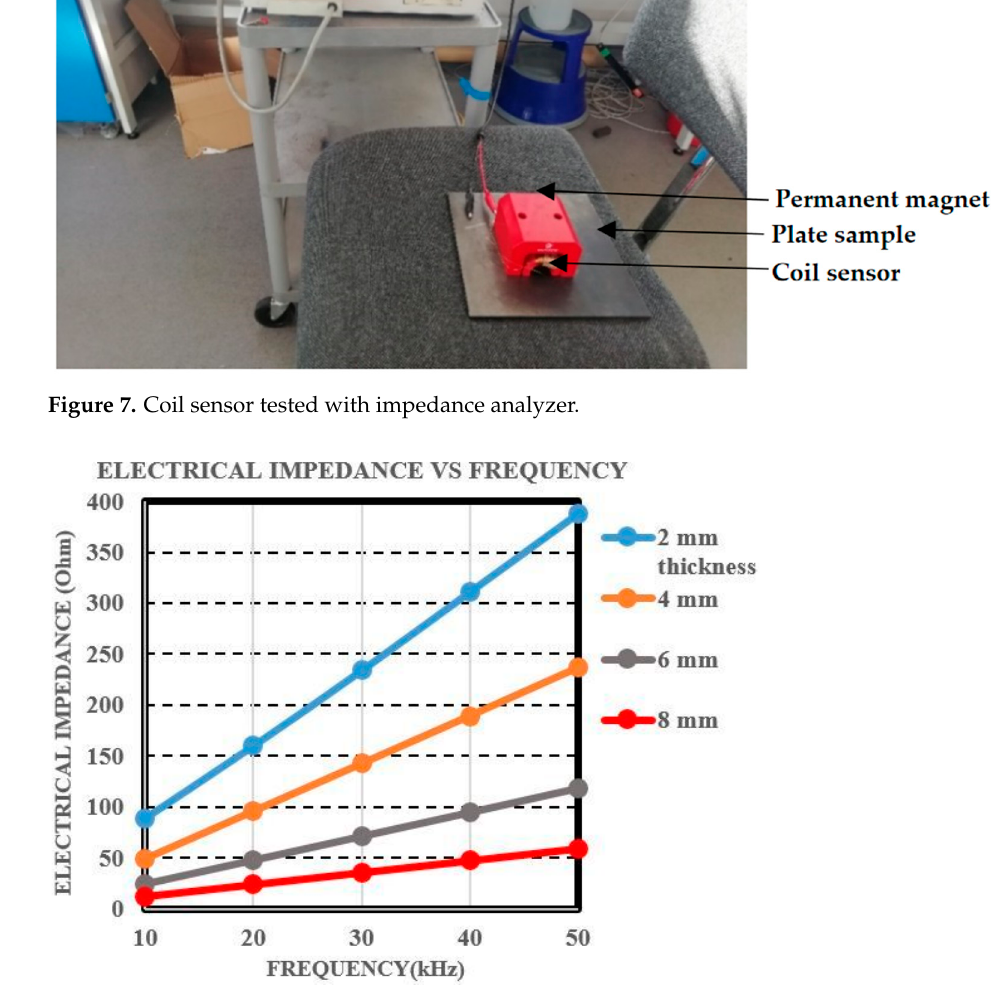
Figure 8. Electrical impedance plot for the varying plate sample thickness.